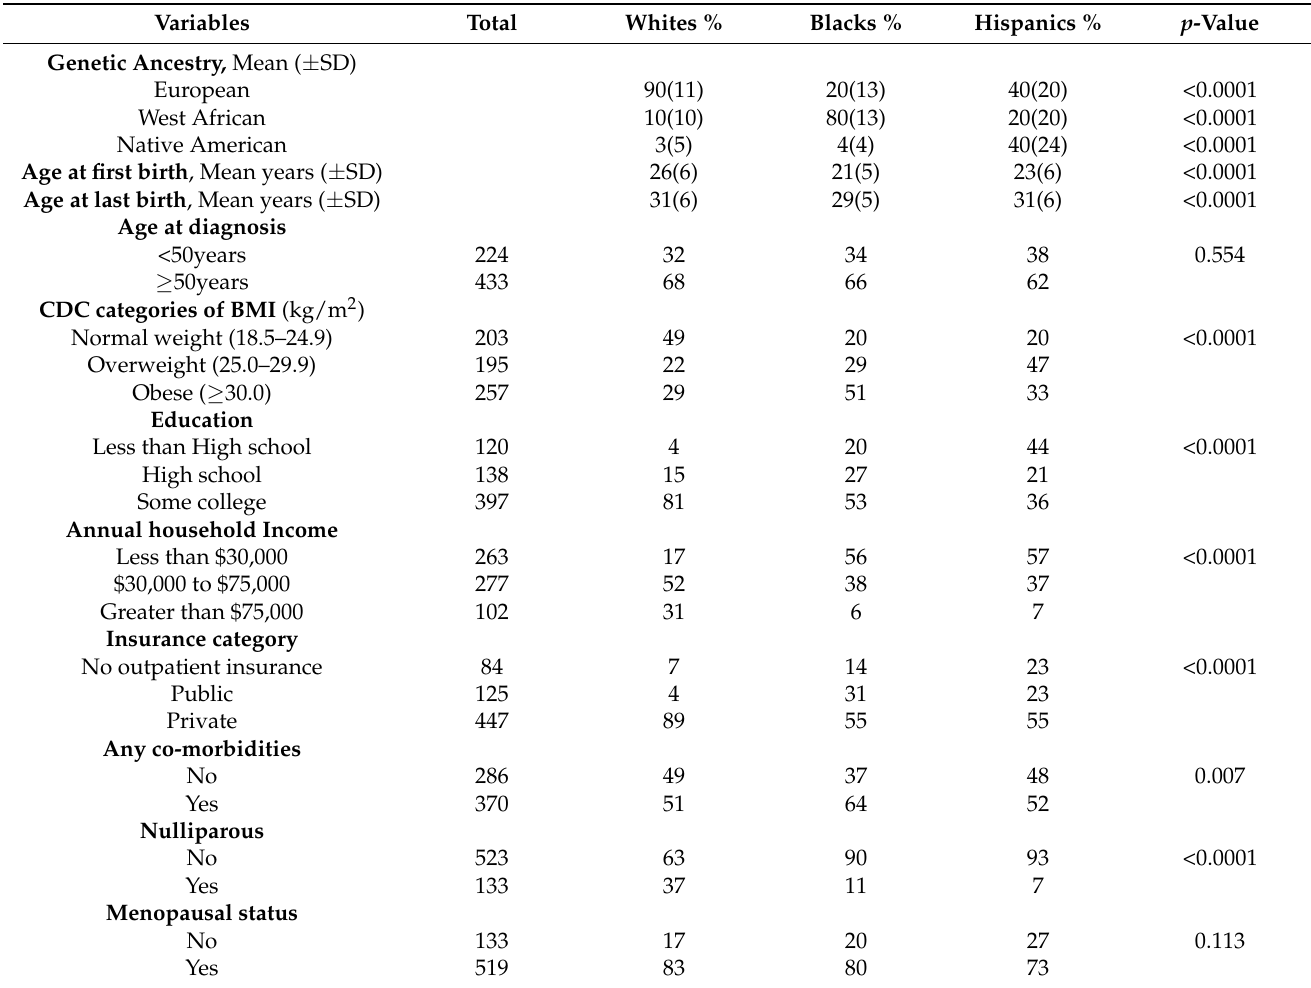
Table 1. Baseline characteristics of the BCCC sample stratified by self-reported